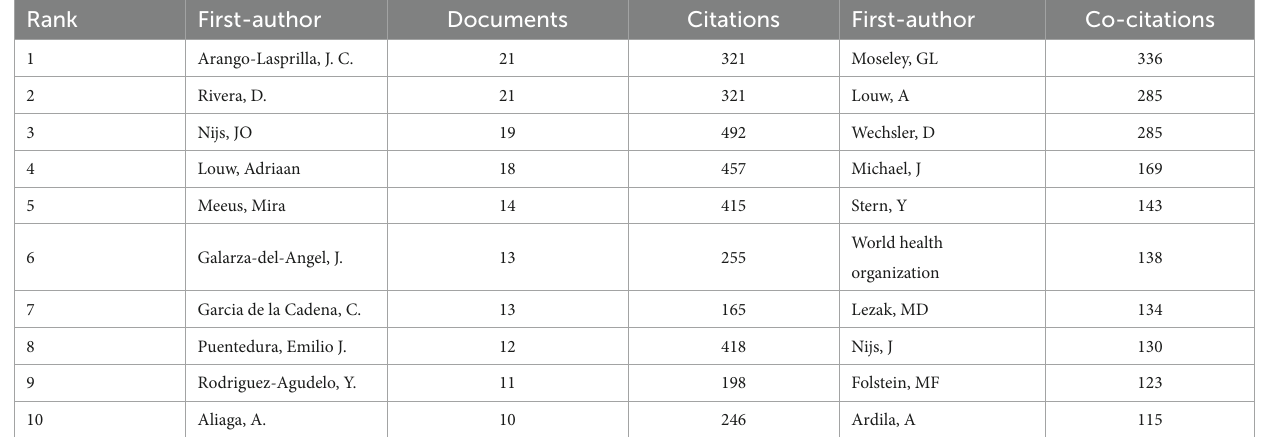
TABLE 2 The top 10 co-authors and co-cited authors of physiology teaching reform